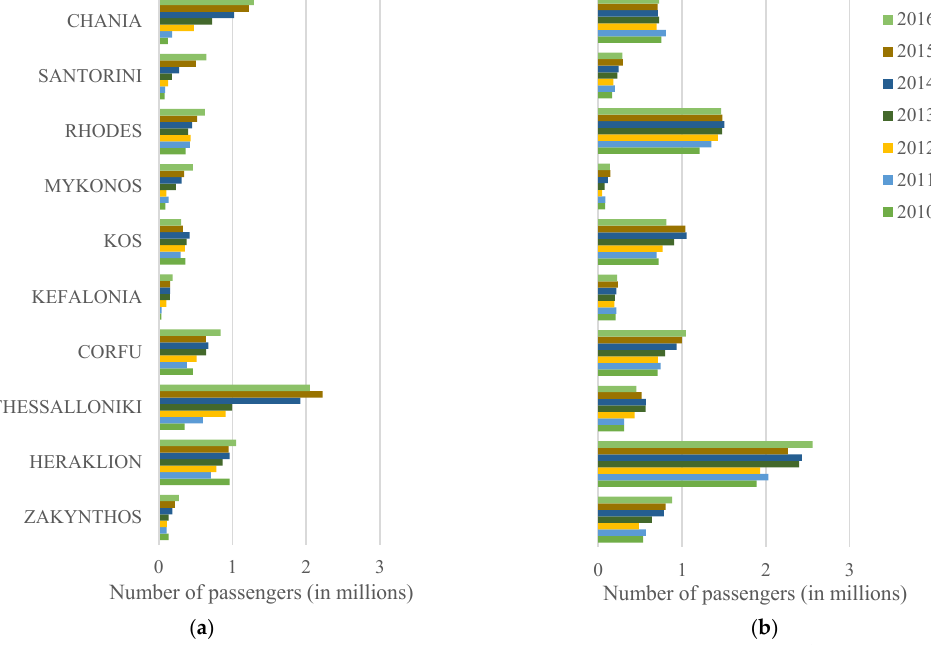
Figure 5. Evolution of passenger traffic for ( a ) low-cost airlines and ( b ) charter flights.